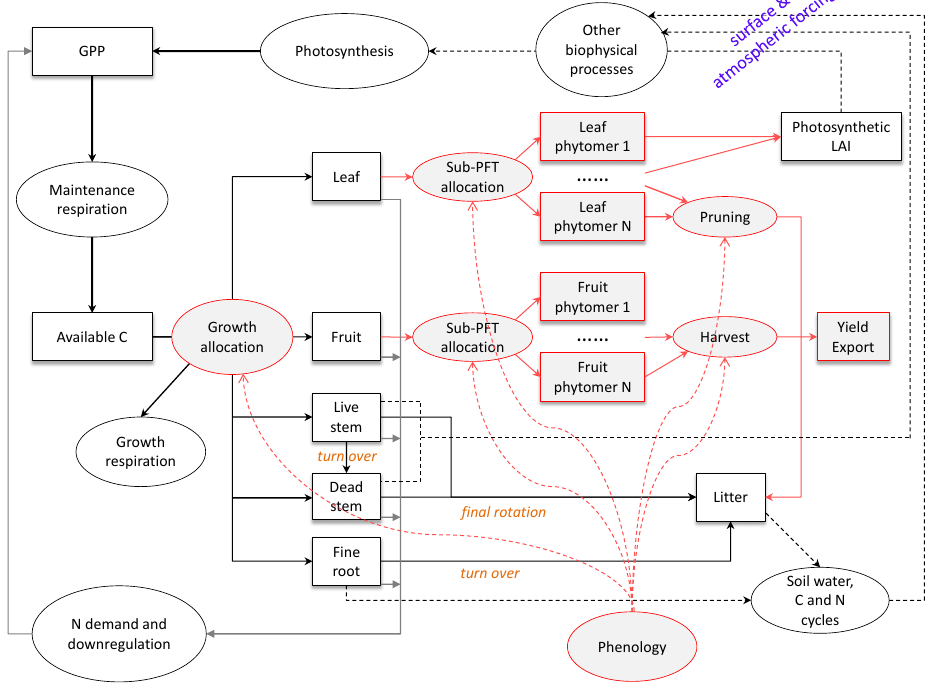
Figure 2. Original and modified structure and functions for developing CLM-Palm in the framework of CLM4.5. Original functions from CLM4.5 are represented in black or grey. New functions designed for CLM-Palm are represented in red, including phenology, allocation, pruning, fruit harvest and export, as well as the sub-canopy (sub-PFT)